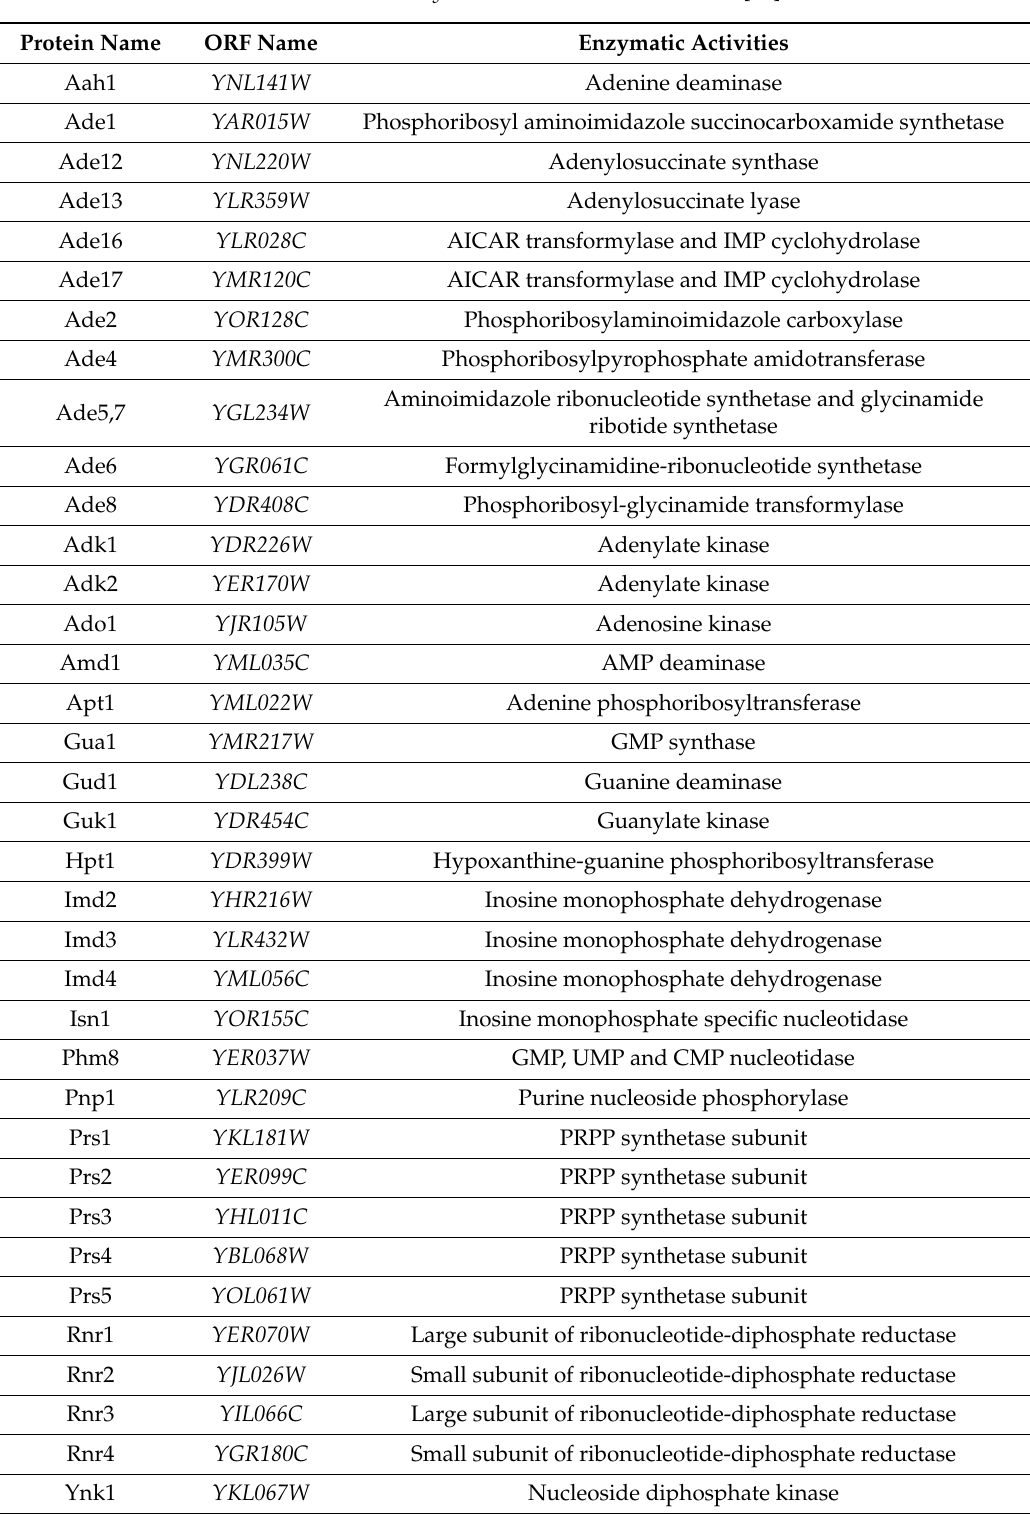
Table A1. List of the Saccharomyces cerevisiae purine pathway enzymes shown in Figure 1. Enzyme features were obtained from the Saccharomyces Genome Database website